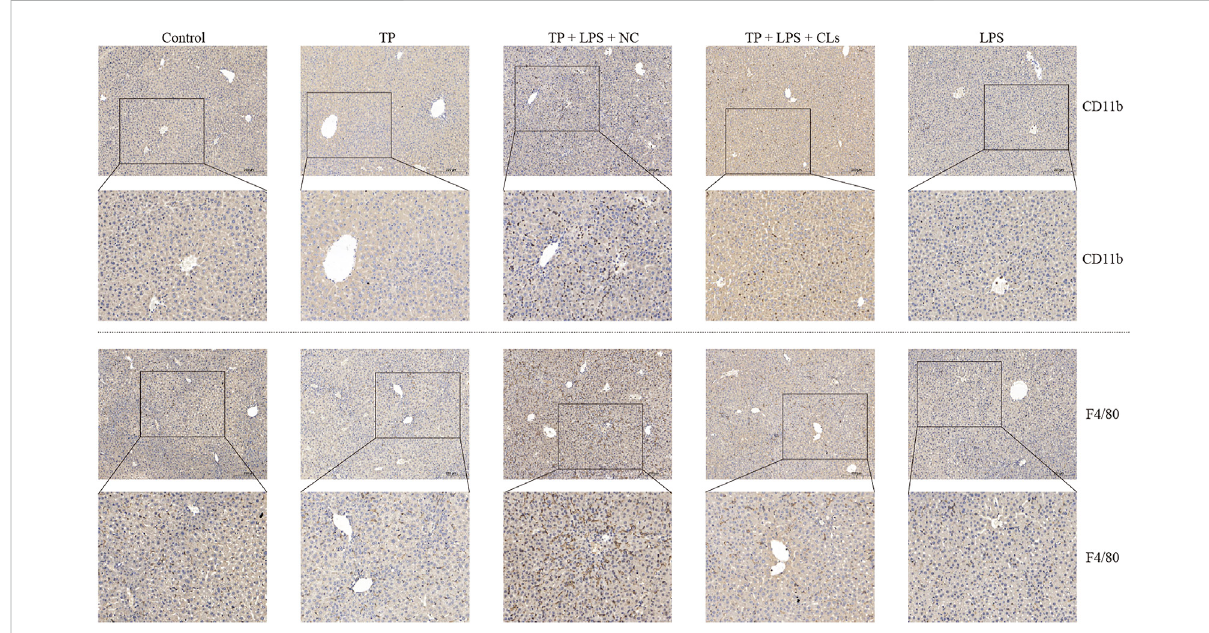
FIGURE 4 Clodronateliposomesadministrationconstrainedtherecruitmentofmacrophagestotheliver.Picturesoflivertissuesectionswereanalyzedby IHC for macrophage markers CD11b (top panels) and F4/80 (bottom panels)